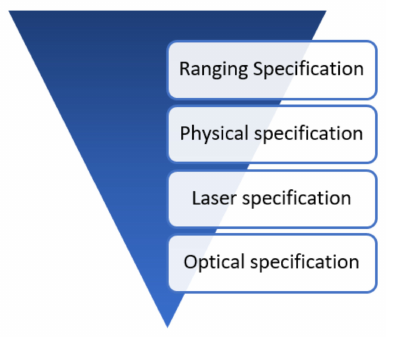
Figure 2. Hierarchy of LiDAR specifications.